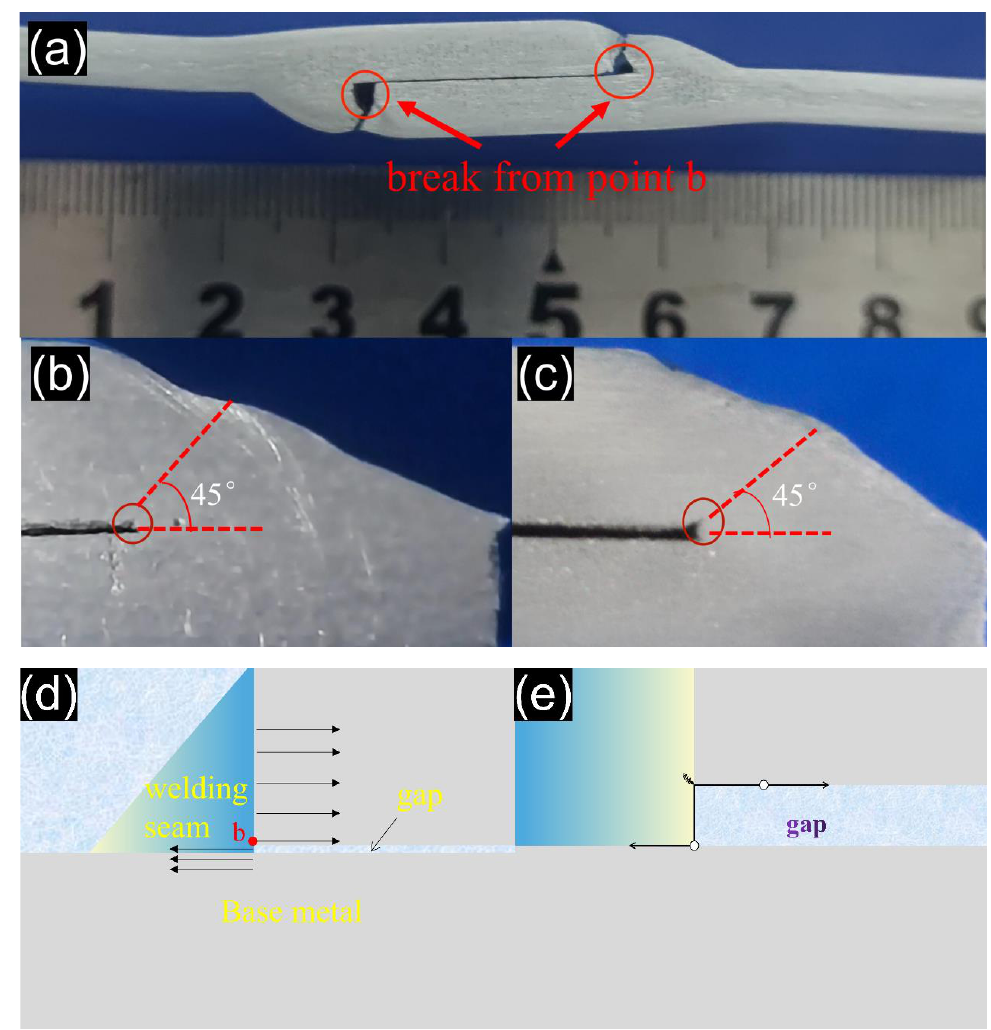
Figure 10. Stress concentration at weld bottom: ( a ) point b fracture, ( b , c ) 45 ° damage at point b when point a fracture, ( d , e ) stress concentration mechanism at point b.